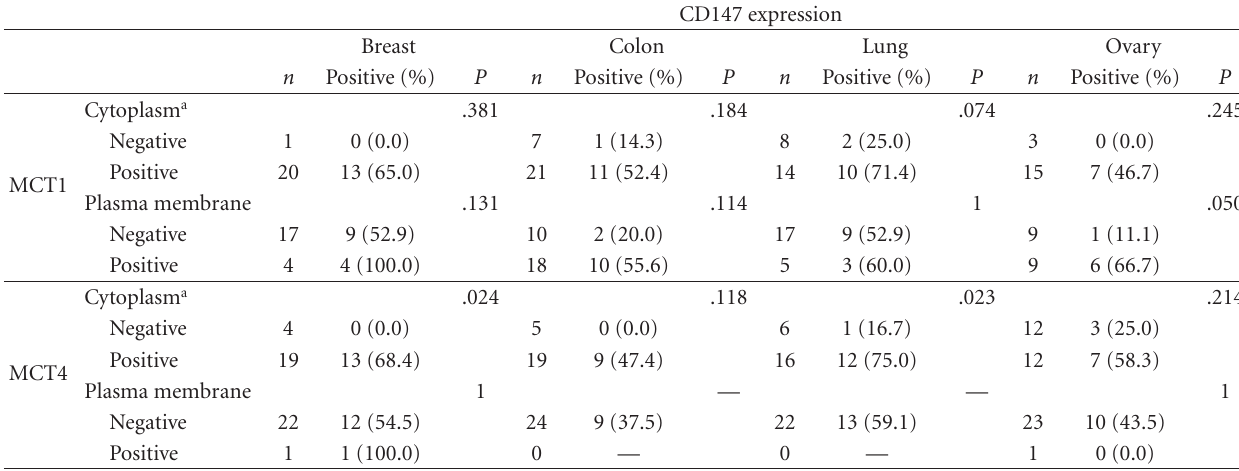
Table 3: Correlations between MCTs and CD147 expressions in tumours.